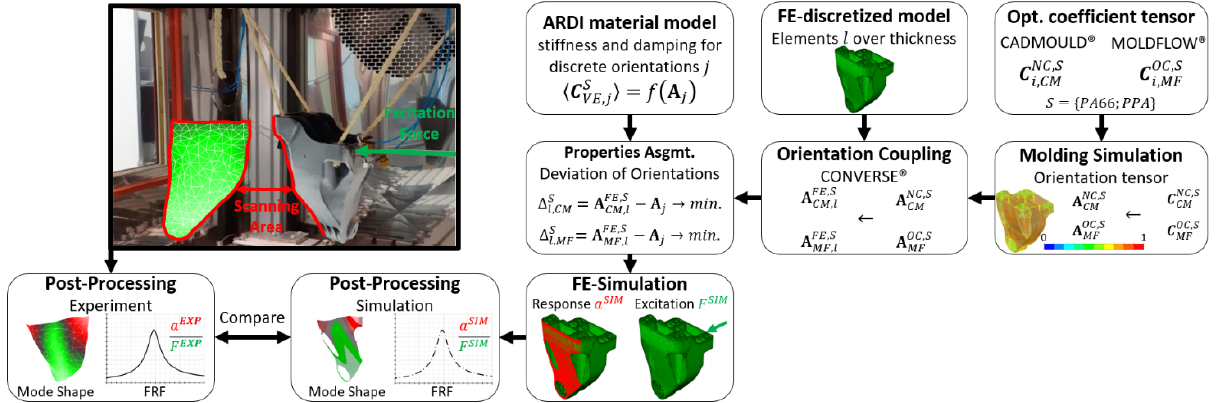
Figure 6. Proposed approach for the experimental and simulative characterization and comparison of the structural dynamics of the short-fiber reinforced thermoplastic engine bracket.